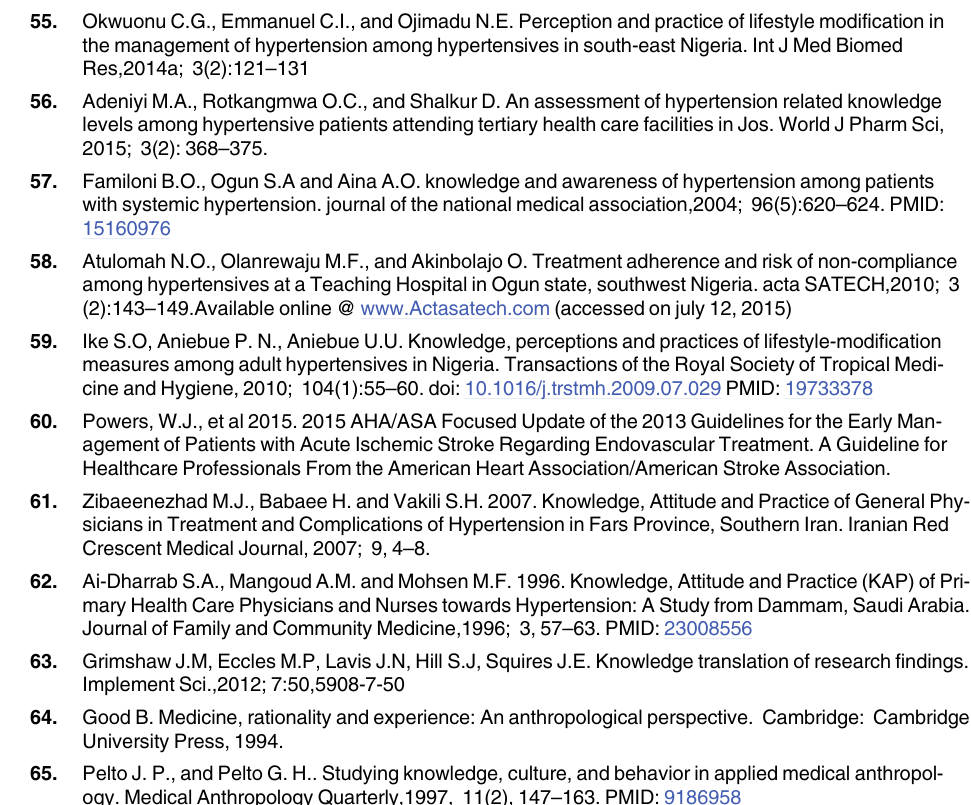
PLOS ONE | DOI:10.1371/journal.pone.0154287 May 5,